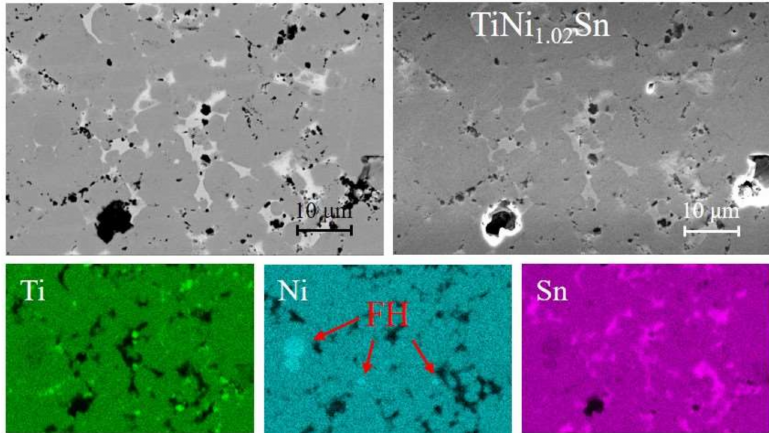
Figure 4. Backscattered electron (BSE, left) and secondary electron (SE, right) SEM images and EDX maps (Ti, Ni, and Sn respectively) for TiNi 1.02 Sn. The elemental maps cover the same area as the BSE and SE